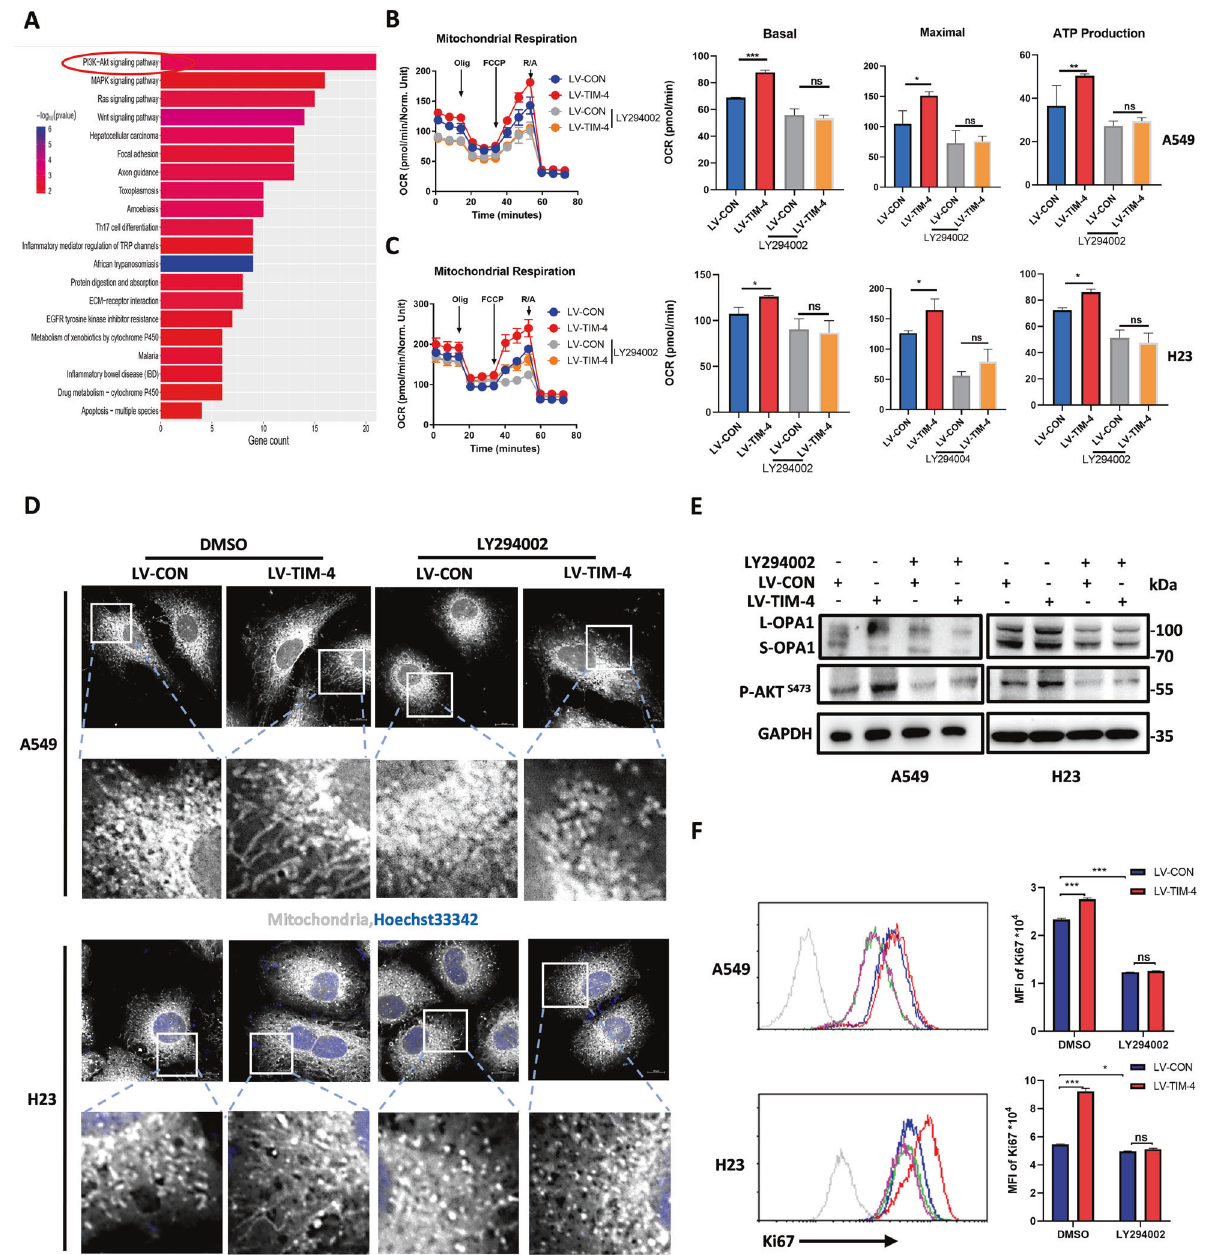
Fig. 4 TIM-4 regulates mitochondrial function through the PI3K/AKT signaling pathway. A Kyoto Encyclopedia of Gene and Genomes (KEGG) analysis showed top enriched gene sets based on RNA-seq data. B , C OCR, mitochondrial basal respiration and maximal respiration of A549 and H23 cells treated with inhibitor of AKT (LY294002, 50 μ M) for 24 h. D Immuno fl uorescent staining of A549 and H23 cells were treated with the indicated inhibitor (LY294002, 50 μ M) for 24 h and mitochondrial phenotype was assessed by TOM20 staining. The scale bar represents 10 μ m. E OPA1 levels and phosphorylation of AKT were assessed by immunoblotting in lung cancer cell lines treated with DMSO or LY294002 (50 μ M) for 24 h. F Flow cytometry histograms showing the level of Ki67 in lung cancer cell lines treated with DMSO or LY294002 for 24 h. Three independent experiments were conducted for each result and error bars represent SEM per group in one experiment. Data were analyzed using Student ’ s t test (two-tailed unpaired t test) for ( B ), ( C ), and ( F ). ns means non-signi fi cance; * P < 0.05; ** P < 0.01; *** P <